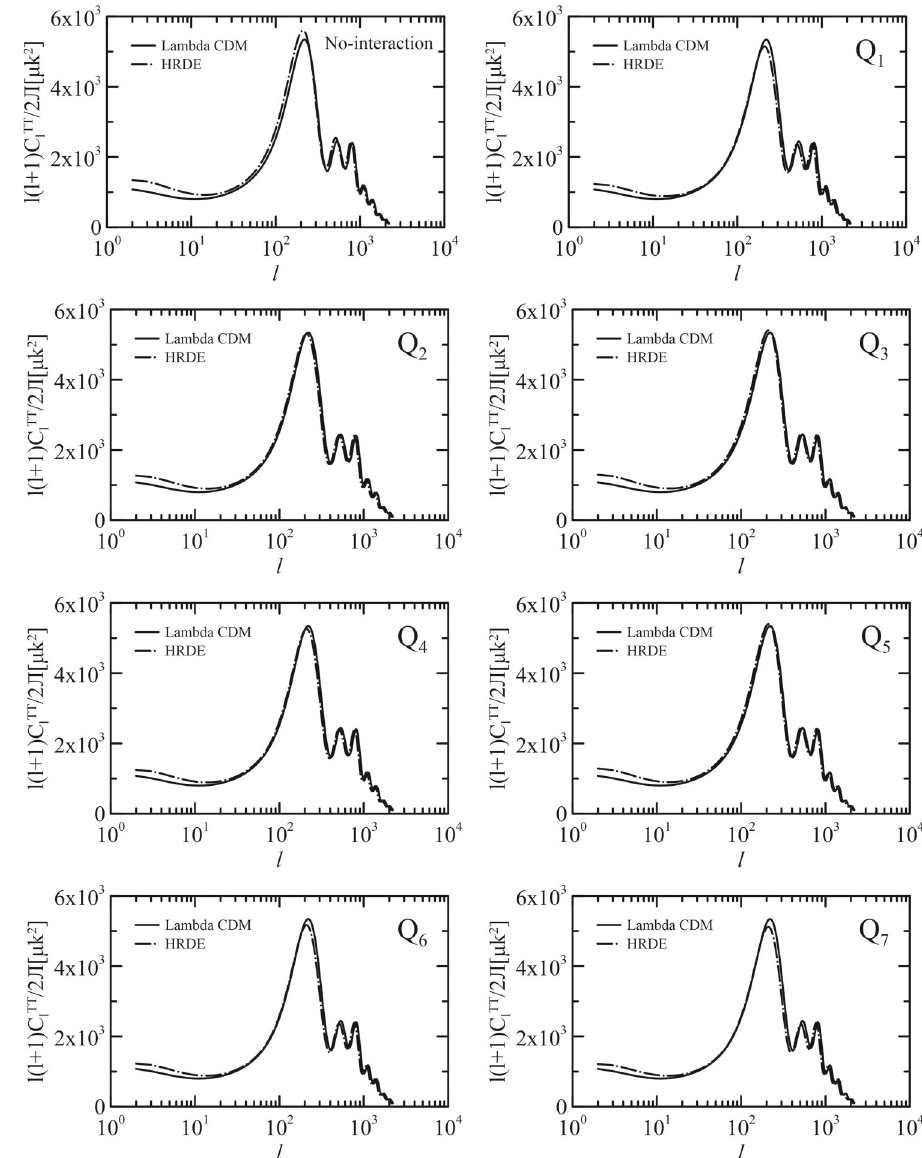
Fig. 5 The CMB temperature spectra c TT (cid:4) of the HRDE (see Eqs. (15), (16)) with interaction terms listed in Table 1. All models’ (cid:5) D and H 0 ≡ 100 h [ km / s · Mpc ] parameter are set as their best fitting values from Table 2 and 3. All models have equal